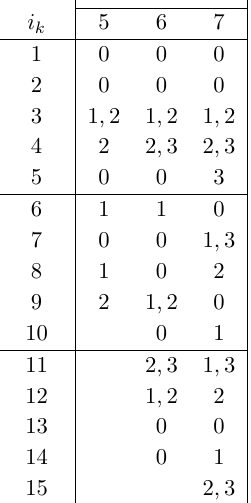
Table 7 . Conformal spectrum in the Z 2 -even sector for the Ising model ( Q = 2). The rank i k of the eigenvalues refer to this sector only, and not to the full spectrum of the corresponding FK model. Rank L